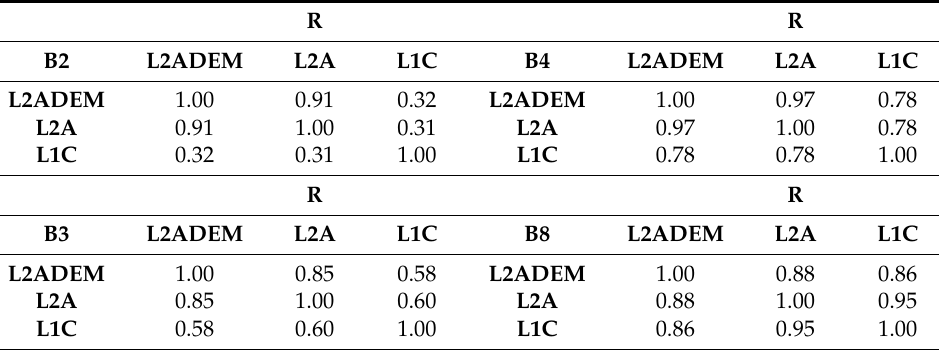
Table 4. Correlation matrices for all endmembers from different data